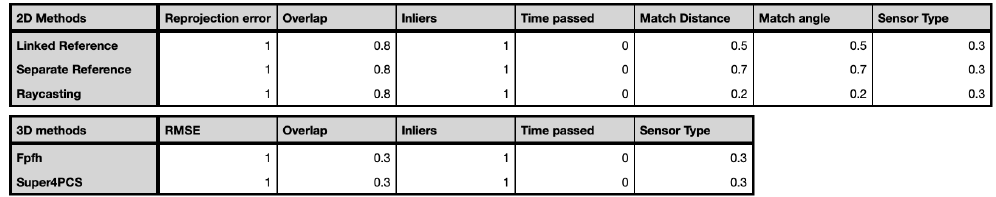
Figure 7. The weighted values of each parameter per method to calculate to